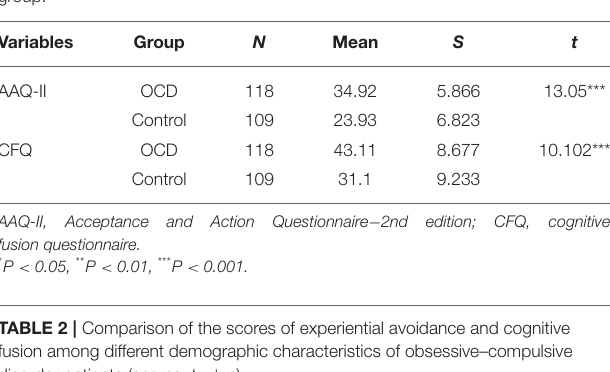
TABLE 1 | Comparison of cognitive fusion and experiential avoidance scores between the obsessive–compulsive disorder (OCD) group and healthy control group.